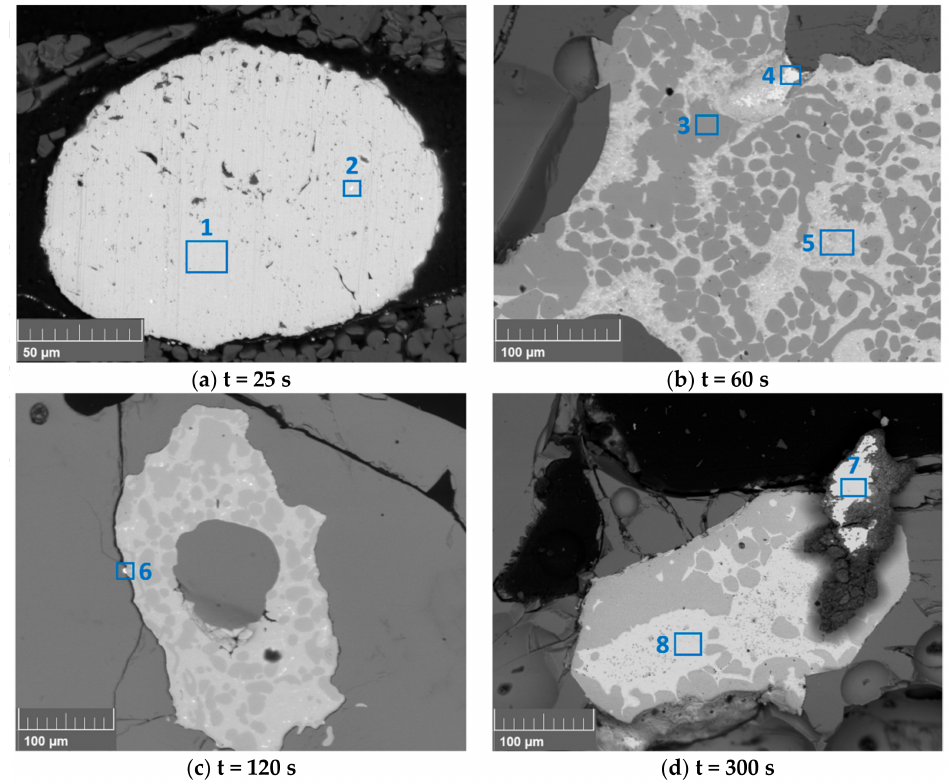
Figure 4. SEM-EDS analysis areas of metal droplets originating from PCB pieces. 1: Cu, 2: Cu–Ni alloy, 3: Fe, 4: Cu–Pb–Sn alloy, 5: Cu–Sn alloy, 6: Cu–Fe–Pb alloy, 7: Pb, 8: Cu–Fe